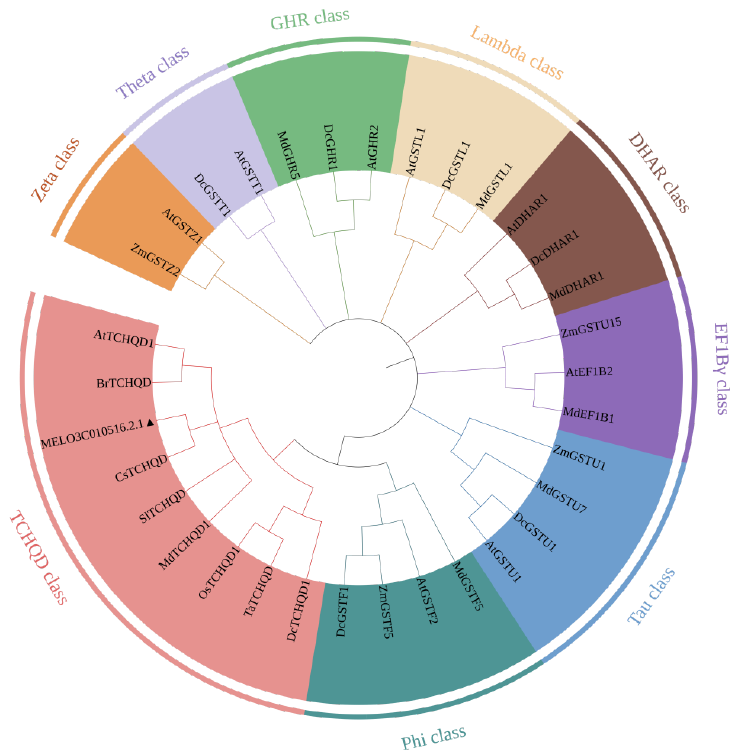
Figure 2. Phylogenetic relationships between MELO3C010516.2.1 ( CmGST TCHQD, highlighted by black triangle) and other plant GST classes. The phylogenetic tree was constructed with the MEGA11 program using maximum likelihood method, and bootstrap analysis was carried out with 1000 replications. The affiliations of the plant GST sequences used in the tree reconstruction are the following: MELO3C010516.2.1 ; C. melo GST TCHQD, CsTCHQD ; C. sativus GST TCHQD